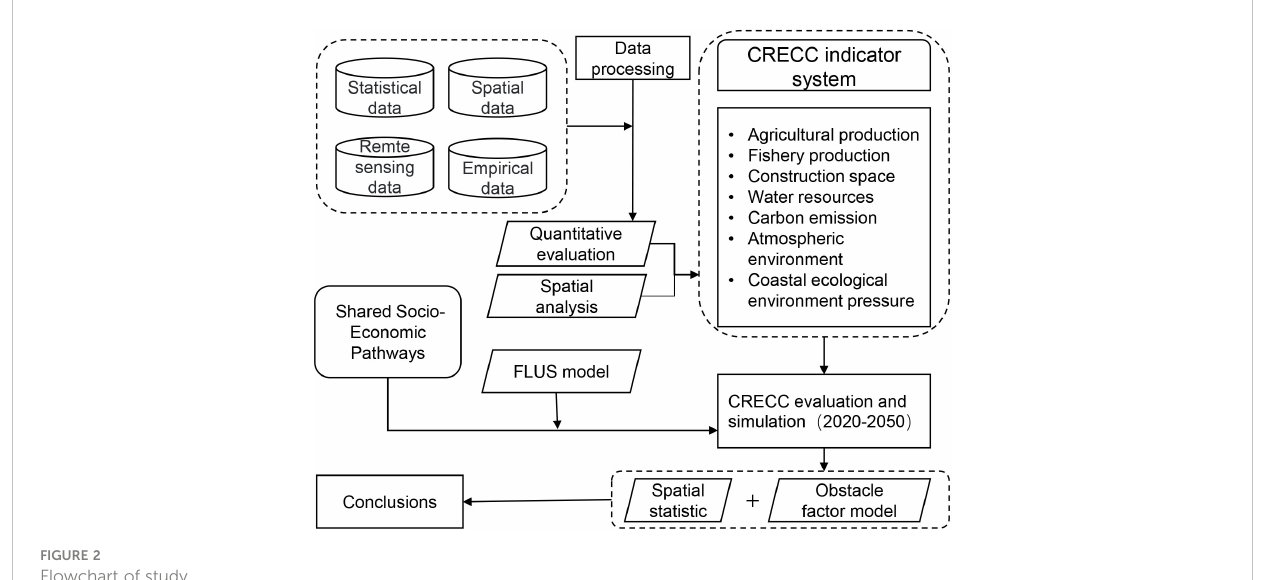
FIGURE 2 Flowchart of